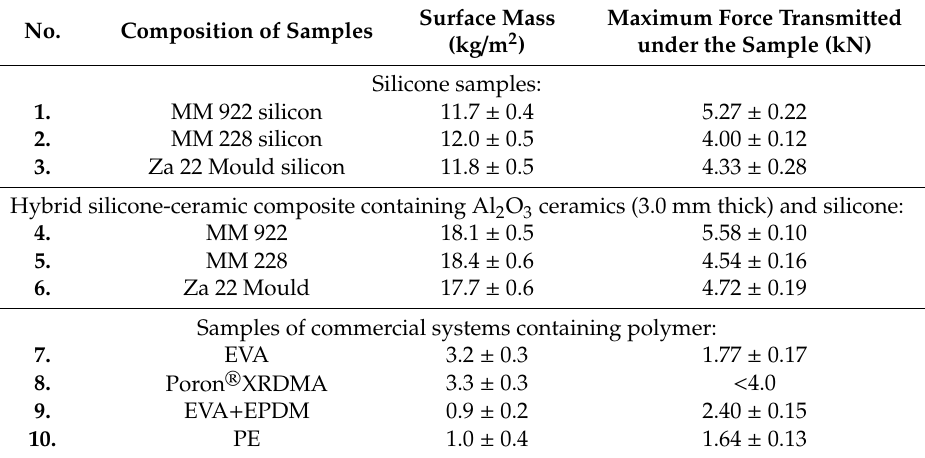
Table 6. Impact test results for the impact energy of 5